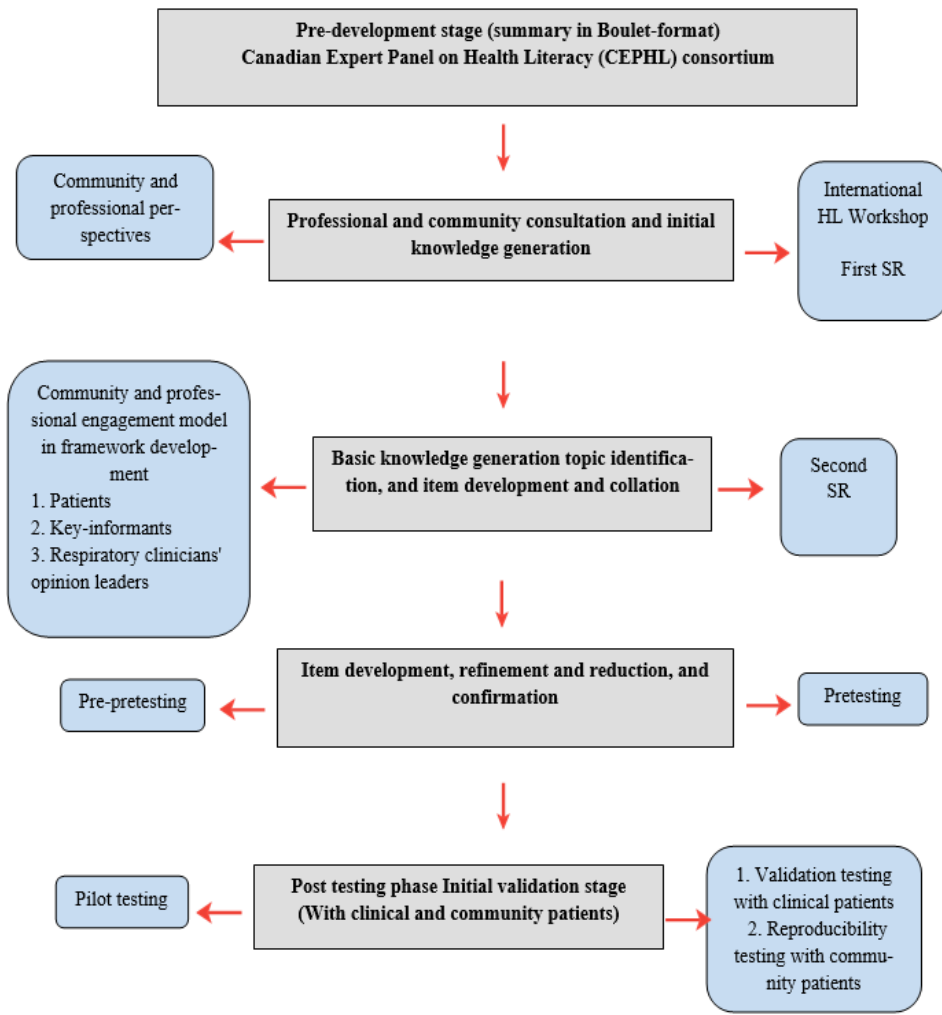
Figure 2. Conceptualization and development of the asthma and COPD disease management health literacy tool: needs assessment and pre-validation stages.